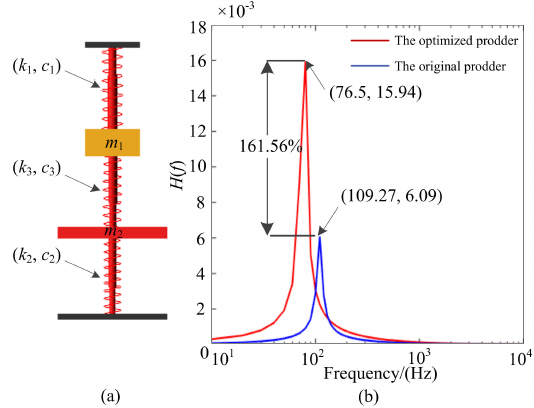
Figure 13. ( a ) Parametric dynamics model of prodder-object system; and, ( b ) Performance comparison between the original prodder and the prodder optimized with the function of Adams